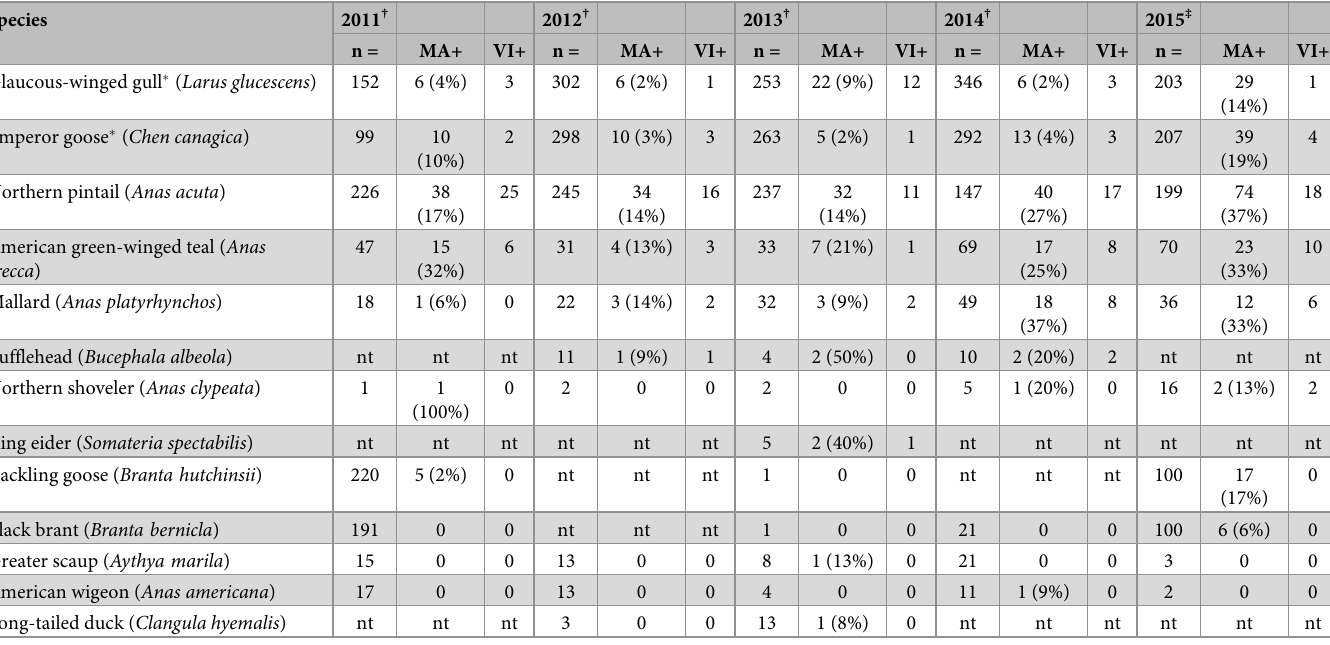
Table 1. Summary of surveillance sampling of wild birds for influenza A viruses at Izembek National Wildlife Refuge, Alaska, USA